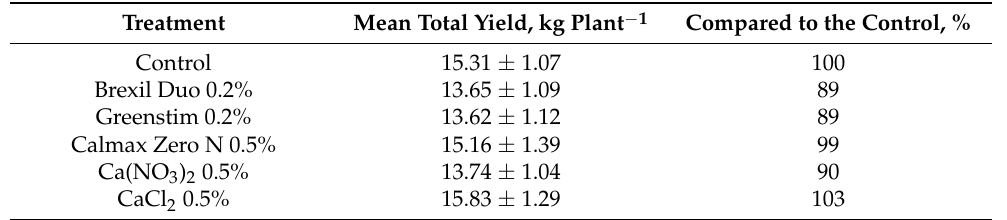
Figure 2. Effect of spraying of Ca-containing/Ca uptake-promoting preparations on Ca content (mass %, dry matter) in different size ‘Beorange’ tomato fruits at the early stages of fruit development ( n = 3). Asterisk (*) indicates a statistically significant difference from the respective control at each sampling time (Kruskal Wallis test, p < 0.05). Table 5. Tomato yield of ‘Beorange’ variety obtained in the greenhouse experiment with sprays of different Ca-containing/Ca uptake-promoting preparations during the season 2020/2021 (cropping period of 28